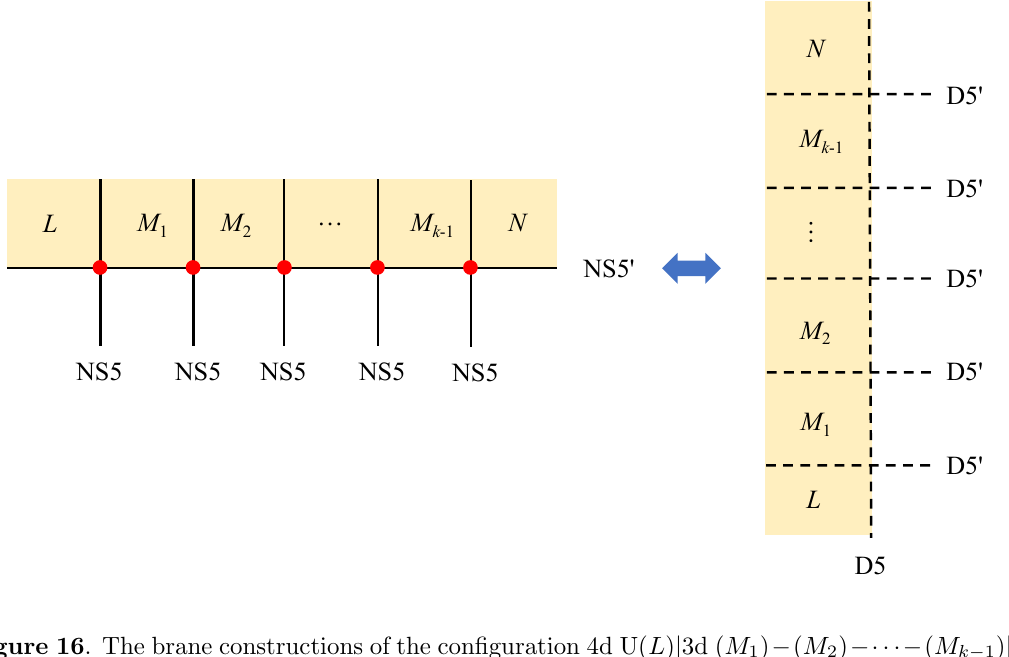
3d ( M ) ( M ) ( M ) 4d 1 2 k 1 | − −· · ·− | −